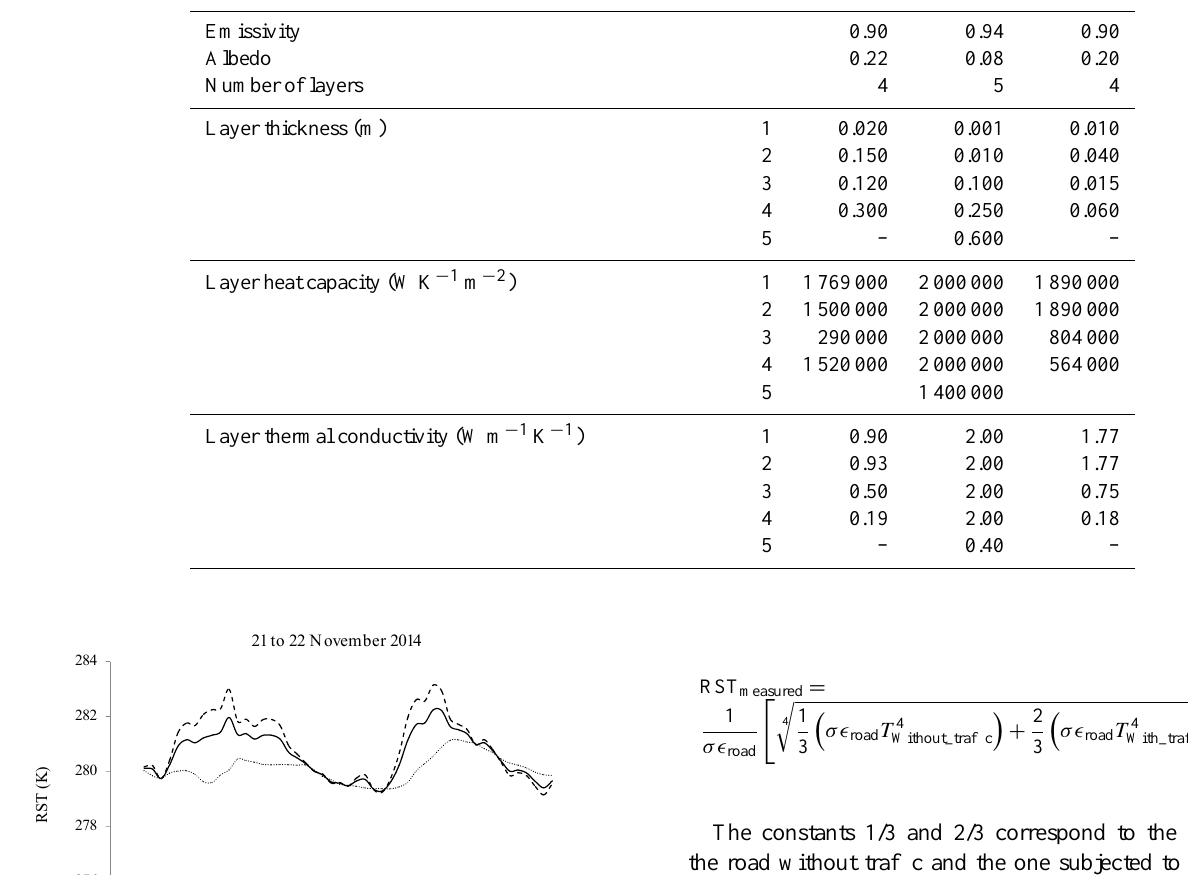
Table 3. Examples of parameterization of the coatings constituting the built urban area in TEB. Item Value Unit Percentage of built area Ratio of the width of the canyon and urban building height Characteristics of the various components of the urban canyon Roof